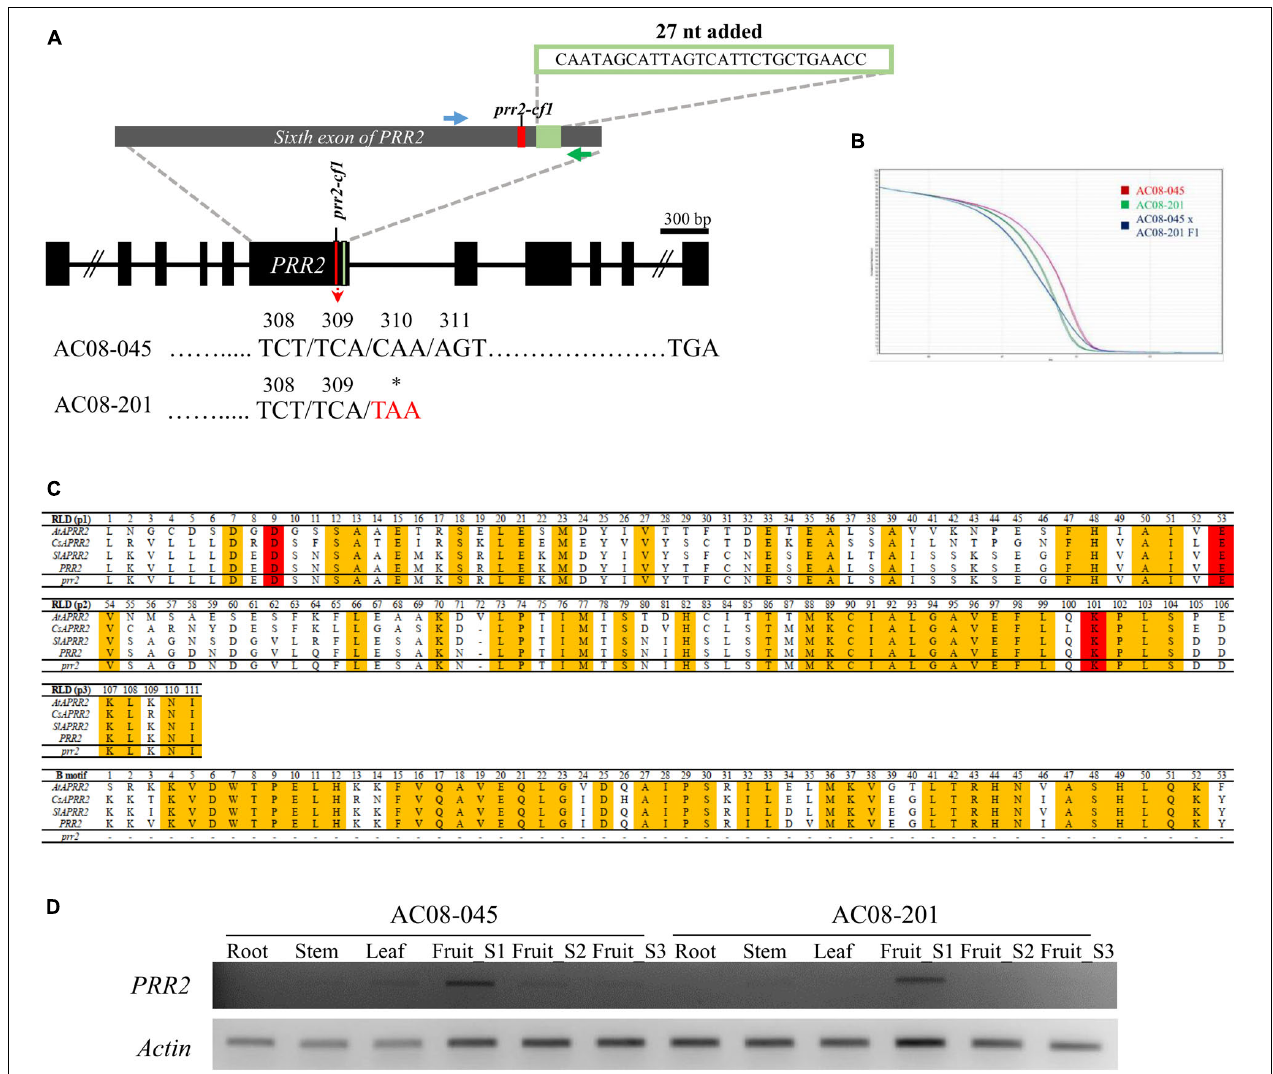
FIGURE 3 | Mutation and HRM markers of PRR2 in AC08-045 and AC08-201, alignment of PRR2 domain between Arabidopsis and three horticultural crops, and expression analysis of PRR2 . (A) Comparison of PRR2 variation between AC08-045 and AC08-201. Variation in the nucleotide sequence and resulting codon change are highlighted in red. A premature stop codon due to a 1-bp substitution was detected in AC08-201. The sixth exon of PRR2 is expanded in the gray exon. Nucleotide sequence of 27-nt insertion observed in this study compared to Zunla v2.0 ( Capana01g000809 ) is shown above. The positions of the designed HRM marker are shown in blue (forward primer) and green (reverse primer). Asterisks indicate stop codons. (B) HRM genotyping of PRR2 . Melting curves are differentiated according to the accessions. Red, green, and blue lines indicate maternal, paternal, and heterozygous type of PRR2 genotype. x axis shows temperature and y axis shows normalized fluorescence. (C) Alignment of PRR2 domain between Arabidopsis and three horticultural crops. AtAPRR2 , CsAPRR2 , SlAPRR2 , and PRR2 refer to the PRR2 genes of Arabidopsis thaliana , Cucumis sativus , Solanum lycopersicum , and Capsicum frutescens , respectively. RLD for receiver-like domain; B-motif for DNA-binding domain. (D) Expression pattern of PRR2 in various tissues. Results of RT-PCR amplification of PRR2 . Roots, stems, leaves, and three stages of fruits were analyzed. In both AC08-045 and AC08-201, PRR2 was exclusively expressed in immature stage (Fruit_S1). Actin served as a control. S stands for stage.